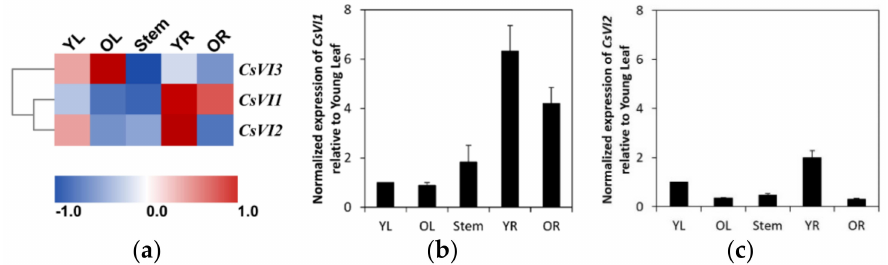
Figure 4. Expression profiles of CsVI genes in different cucumber tissues. ( a ) Transcriptomic analysis of the expression of CsVI s illustrated as a heat map. The scale represents the range of gene expression of CsVI s as RPKM in different samples after Z -Score standardization [35]. ( b ) Real-time PCR analysis of transcript abundance of CsVI1 . ( c ) Real-time PCR analysis of the transcript abundances of CsVI2 . Young leaf, YL; older leaf, OL; Young root, YR; older root, OR. Results are means of >3 biological replicates ( ± SE) each with three technical